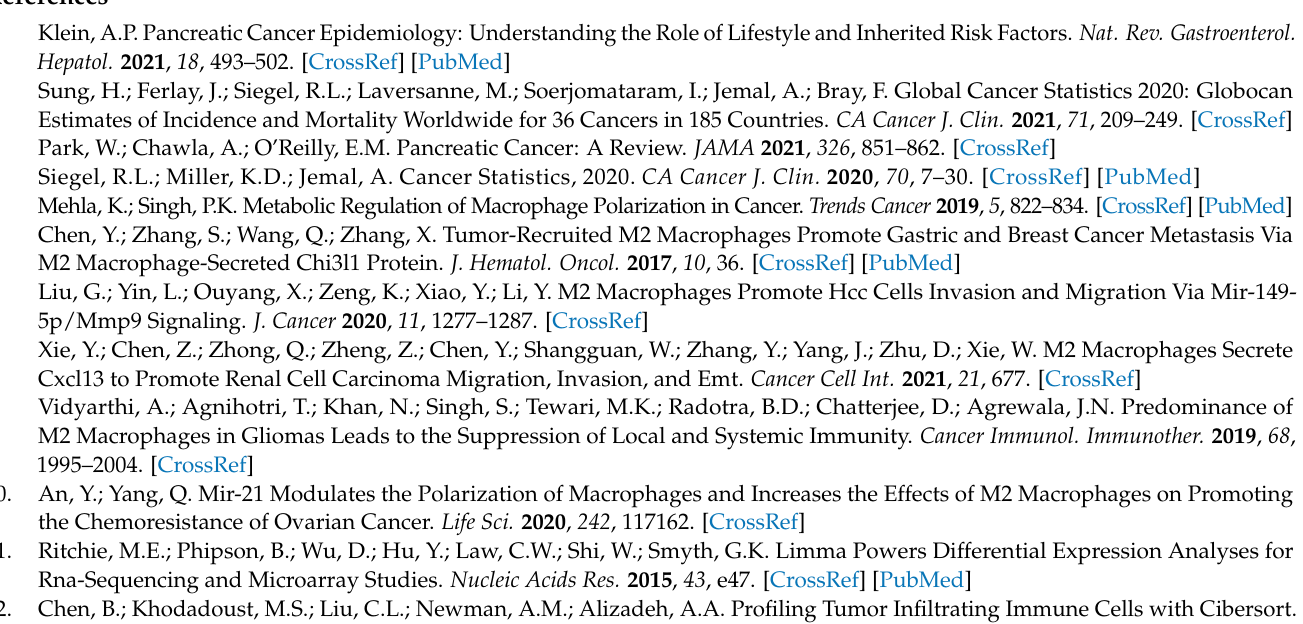
macrophages; Figure S2: Kaplan-Meier survival curves of TMIGD3; Figure S3: Single cell analysis of